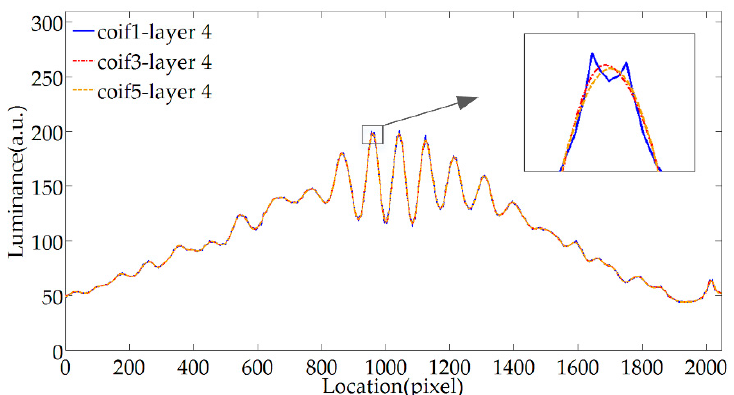
Figure 5. Filtering effect of different wavelet orders.